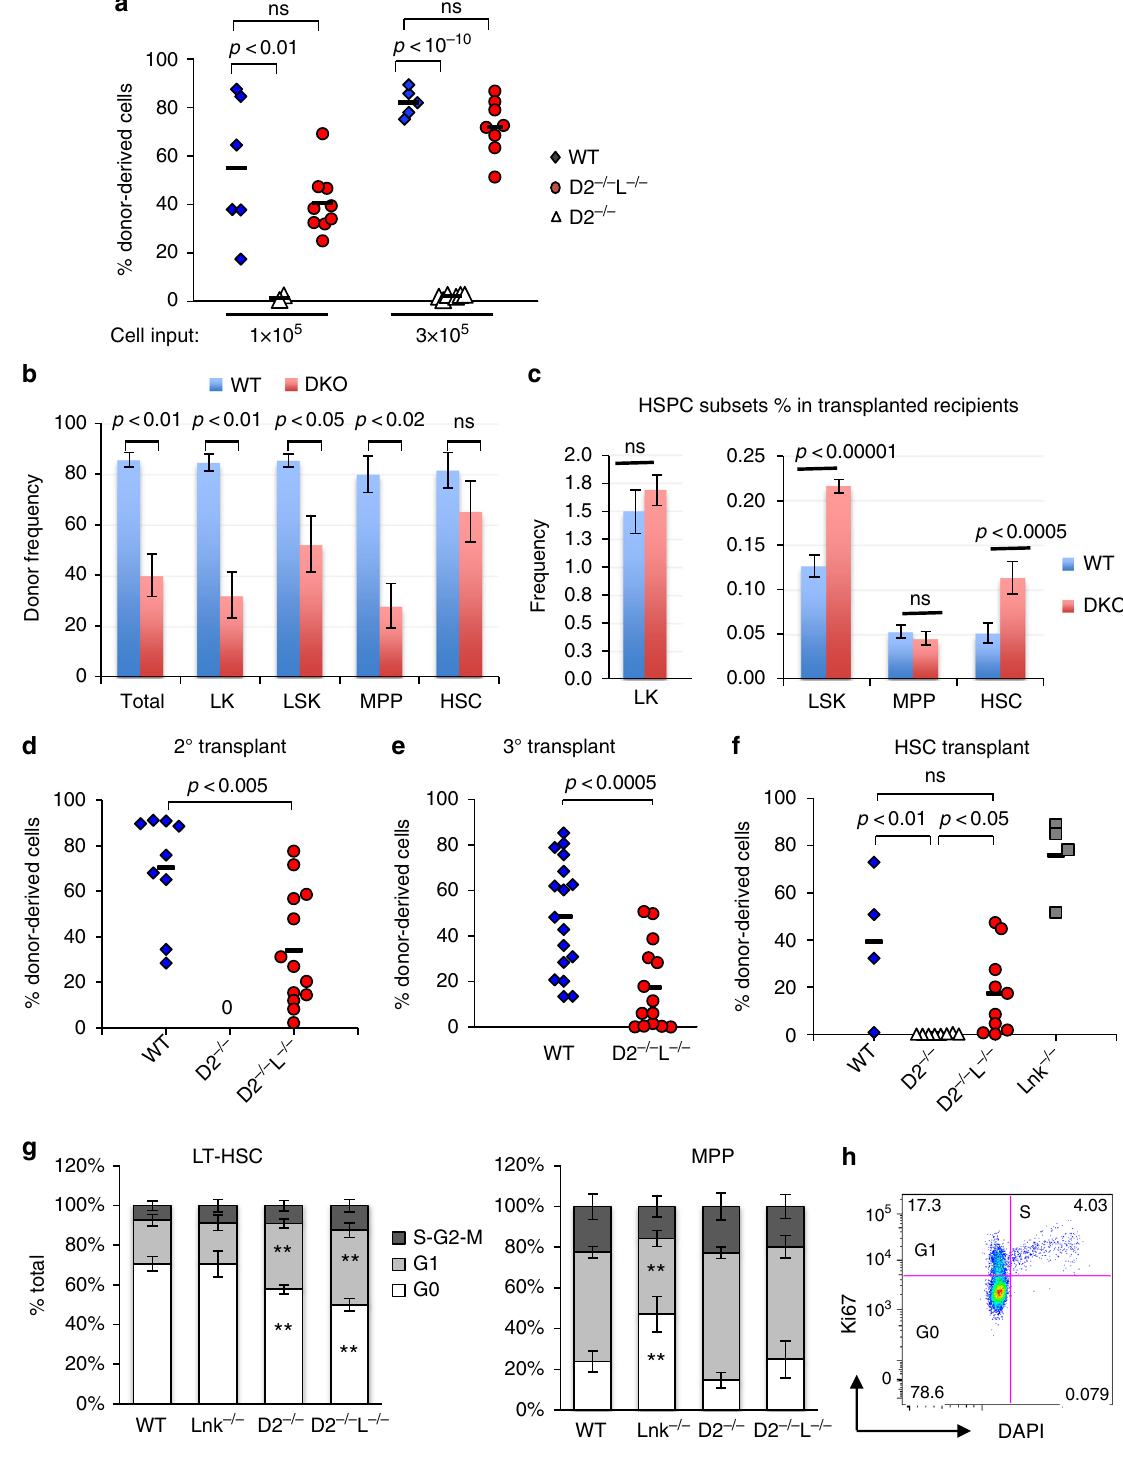
by HU (Fig. 6c, d). Single DNA fi bers were spread onto microscope slides before immuno fl uorescence staining with antibodies against IdU and CldU to measure relative fork length (CldU/IdU ratio). The relative shortening of the CIdU tract after HU treatment serves as a measure of replication fork